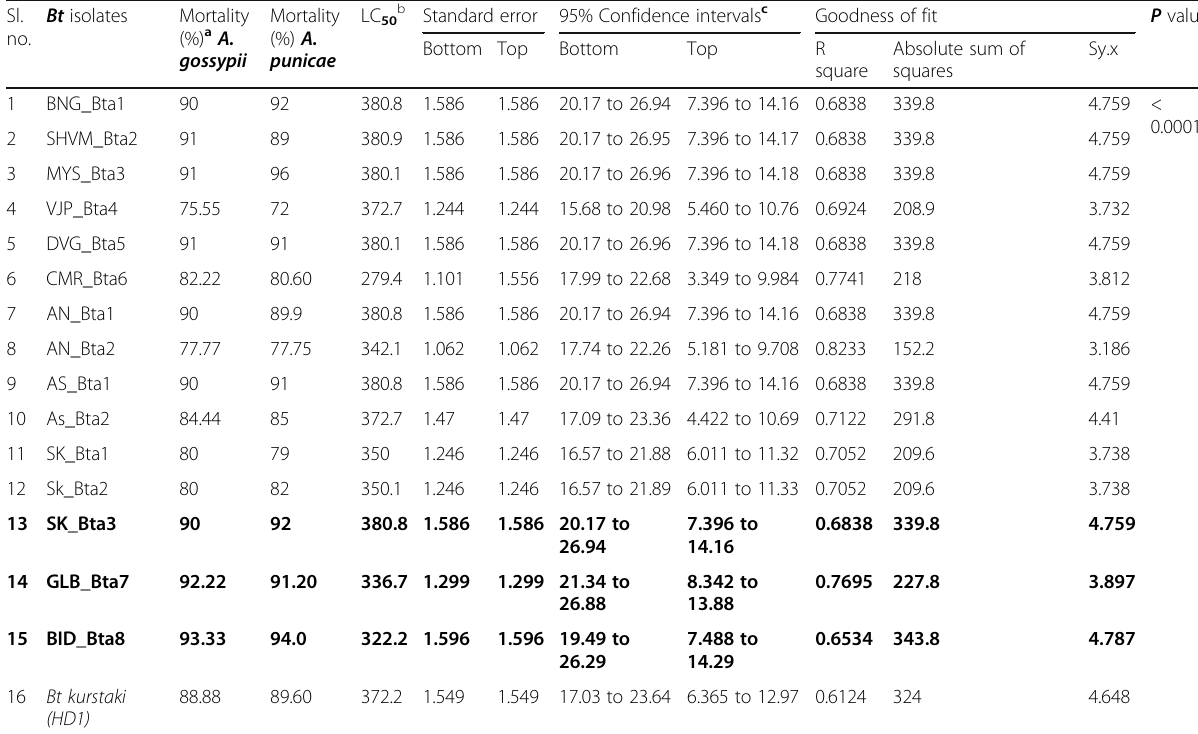
Table 4 Insecticidal activity of the native B. thuringiensis isolates against A. gossypii and A. punicae adults Sl. Bt isolates no.